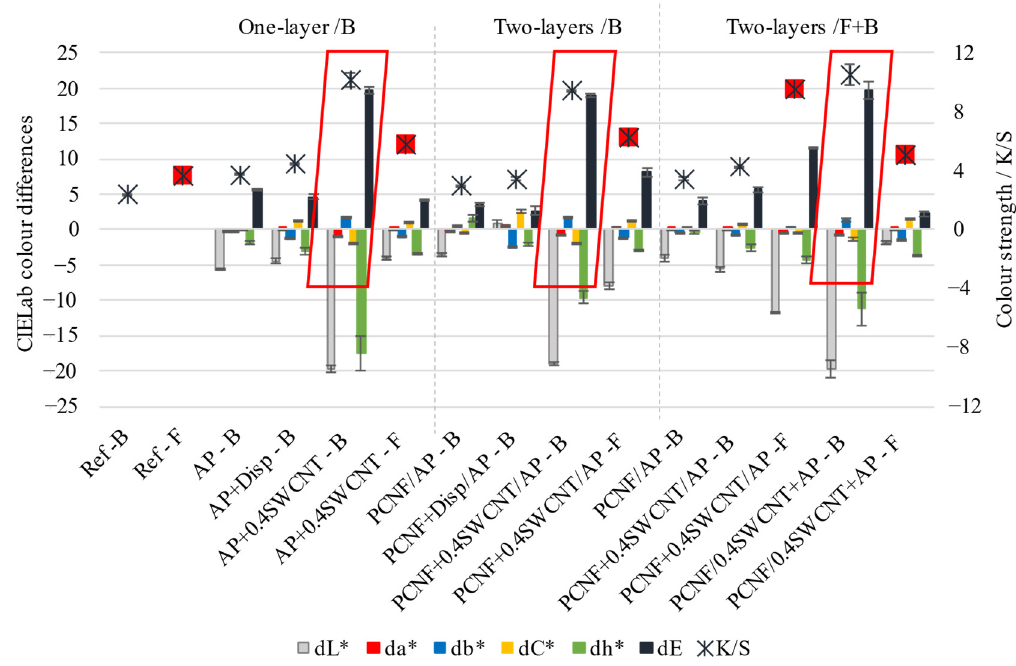
Figure 2. The effect of printing on the fabric’s colour strength (K/S) and CIEL*a*b* colour differences in lightness (dL*), saturation (dC*), red–green (da*) and yellow–blue (db*) axes, as well as total values (dE), determined on the back/B (turned outwards) and front/F-side (facing the wearer) of the fabric.